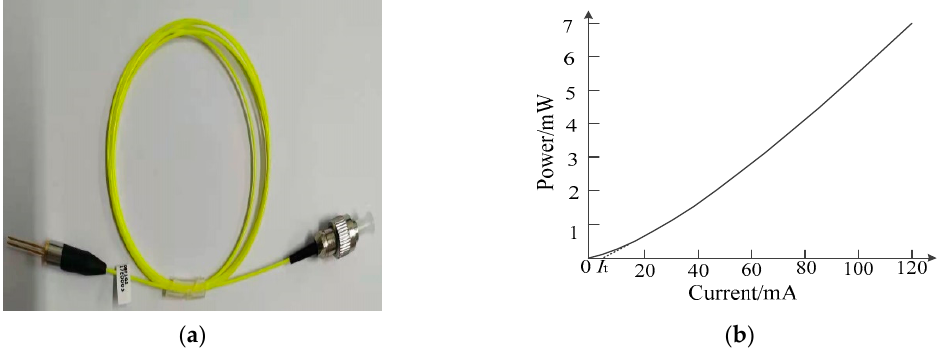
Figure 4. The physical diagram ( a ) and its output characteristic curve ( b ) of the semiconductor laser.